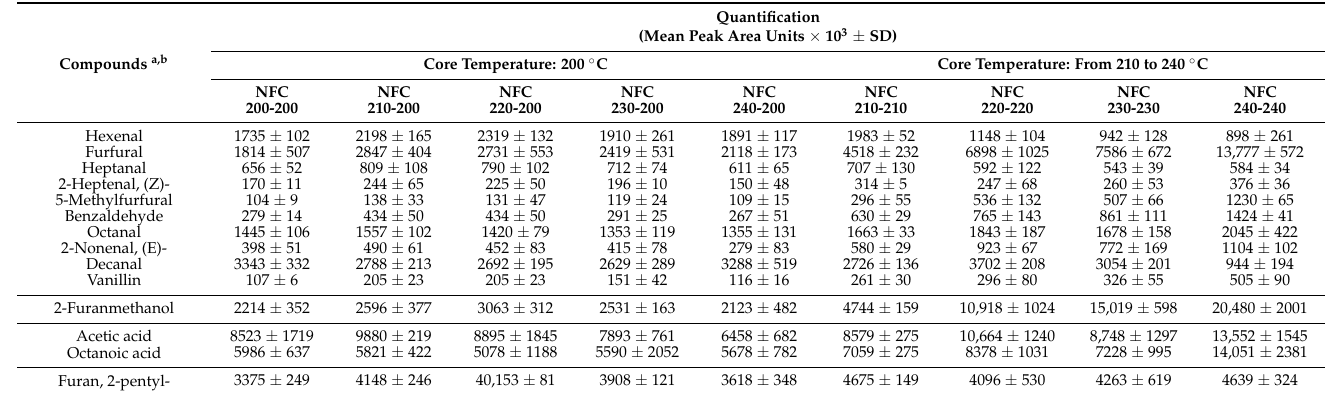
Table A2. Volatile organic compounds coming from flax fibers of NFC shaped for heat press tempera- tures between 200 and 240 ◦ C for different core temperature